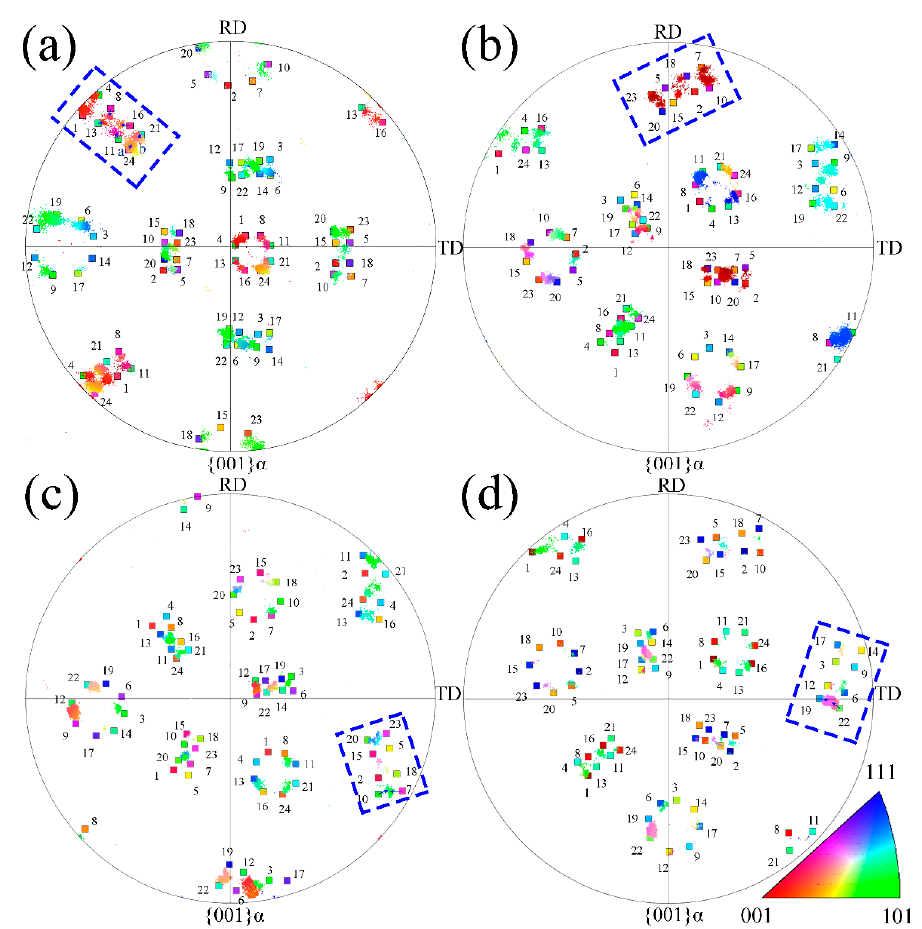
Figure 6. The determined {001} inverse pole figure of the bainitic ferrite and the comparison with the calculated variants of K-S relationship of the selected areas of microstructures transformed at ( a ) 200 ◦ C; ( b ) 250 ◦ C; ( c ) 300 ◦ C and ( d ) 350 ◦